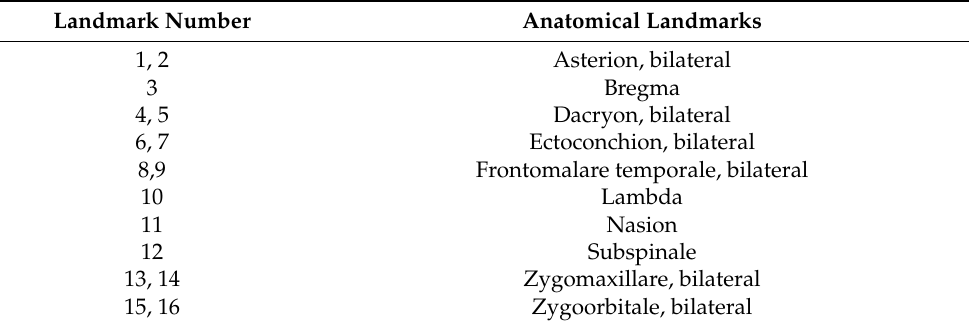
Table 2. Anatomical landmarks and associated